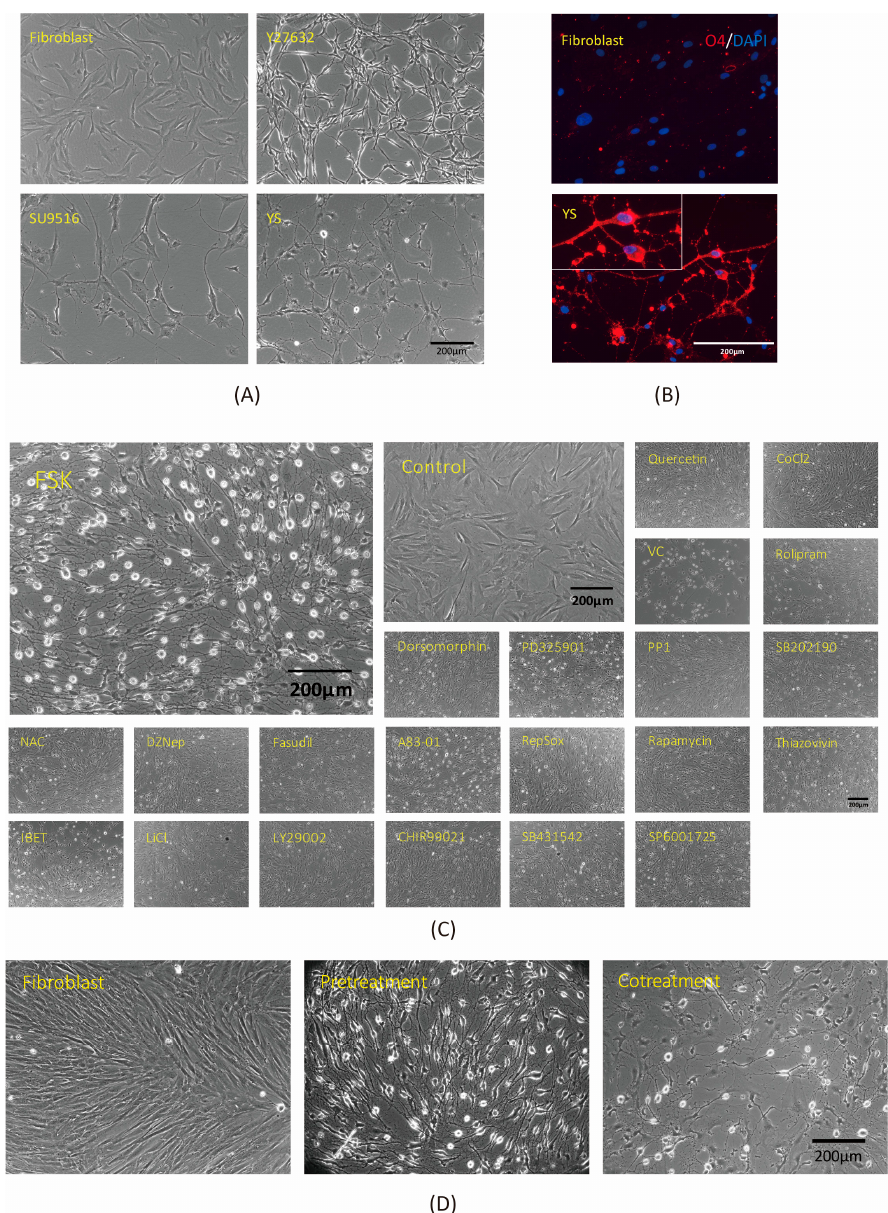
Figure 1. High-throughput screening of small molecules for conversion of fibroblasts into oligodendrocyte-like cells. ( A ) Fibroblasts changed cell morphology after treatment with different chemicals. Phase-contrast images represent solvent control (fibroblasts) (top left), Y27632-treated fibroblasts (top right), SU9516-treated fibroblasts (bottom left), and fibroblasts treated with a combination of Y27632 and SU9516 (bottom right). ( B ) Immunofluorescence staining showed the oligodendrocyte-specific marker O4 on induced cells (red). DAPI (blue) was used to stain nuclei. ( C ) We tested 1540 chemicals, and the candidate molecules that promoted reprogramming were screened on the basis of Y27632 and SU9516 after valproic acid (VPA) treatment. These images show different chemical combination treatments of fibroblasts. Forskolin (FSK)-treated cells maintained dome-shaped cell morphology and dendritic structures. The ingredients of ‘VYSF’ included valproic acid, Y27632, SU9516, and forskolin. ( D ) Testing of VPA. Pre-treated and co-treated VPA with ‘YSF’ cocktails. Fibroblasts were treated with VPA for 2 days and then treated with the YSF mixture for 1 day or fibroblasts were co-treated with VPA and YSF mixture for 1 day. Phase-contrast images representative of solvent control (fibroblasts) (left), VPA pre-treatment (middle), and VPA combination treatment (right) of cells are shown. VYSF refers to valproic acid, Y27632, SU9516, and forskolin,